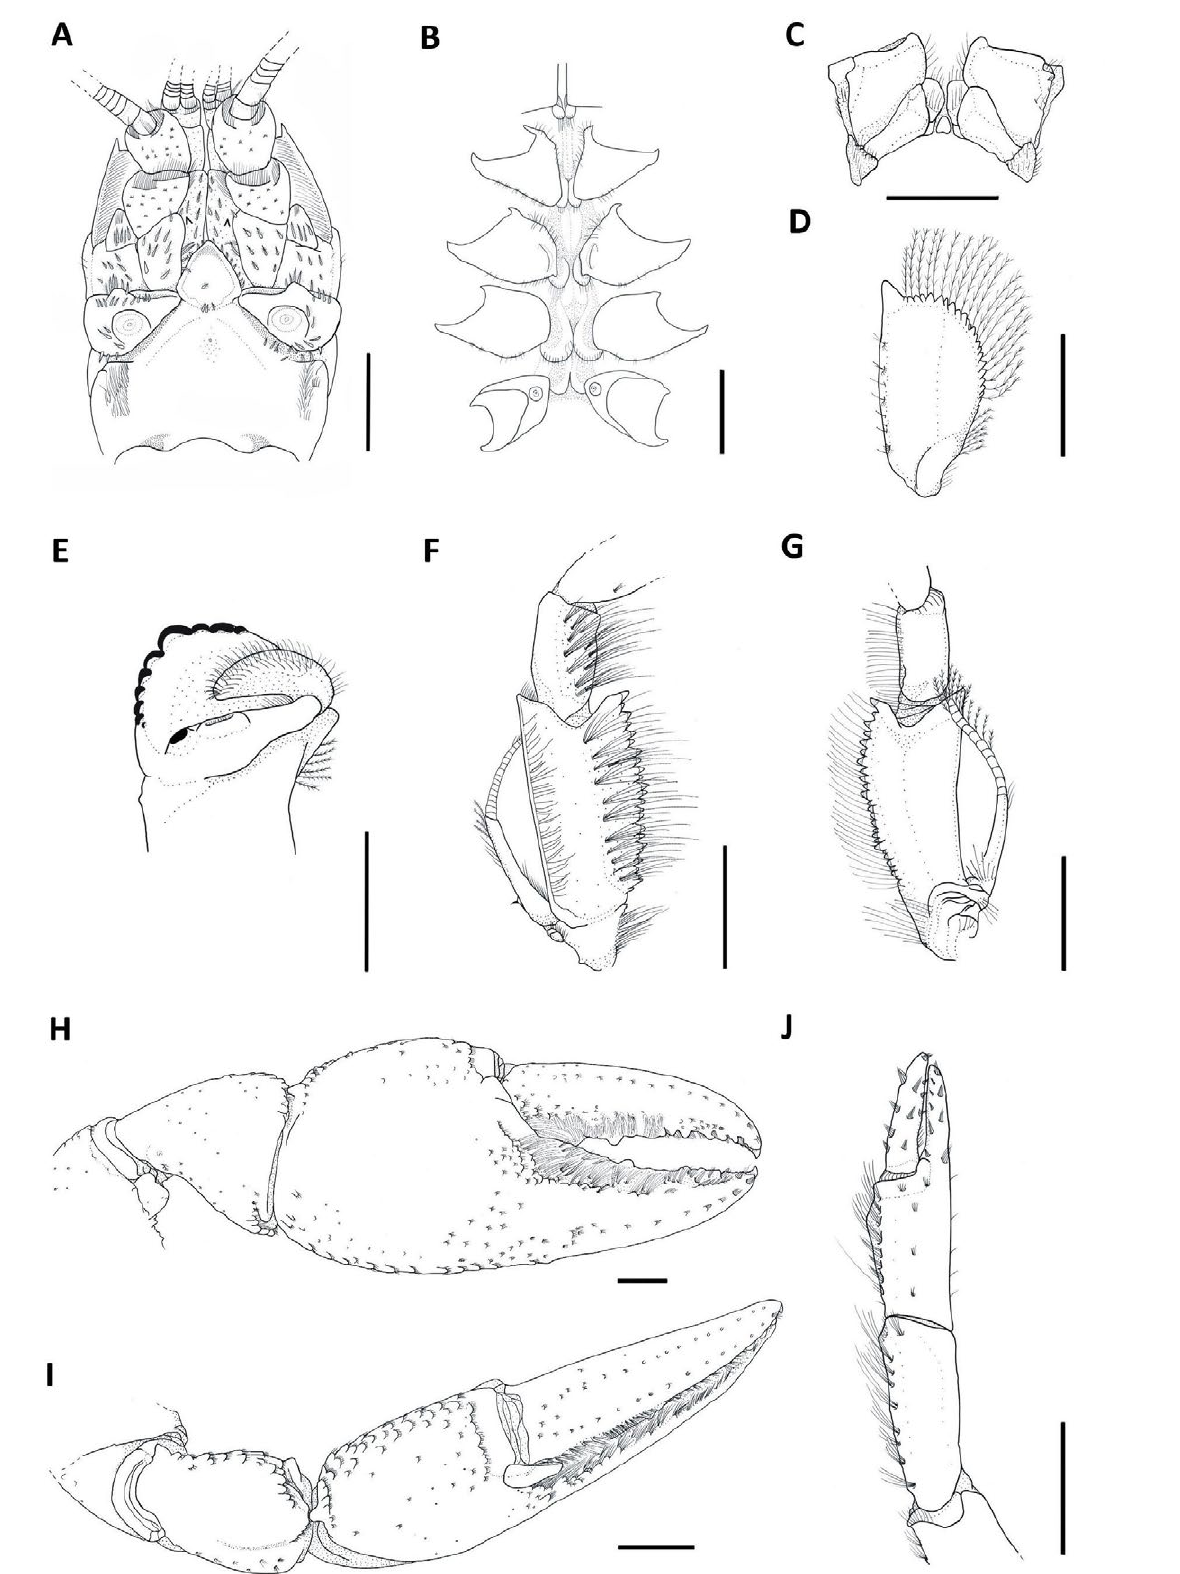
Figure 2. Parastacus buckupi sp. nov. A, epistome (holotype); B, thoracic sternites and gonopores (holotype); C, thoracomere 8, caudal view (holotype); D, antennal scale lateral view (paratype 4); E, mandible (paratype 4); F, third maxilliped ventral view (paratype 4); G, third maxilliped dorsal view (paratype 4); H, first pereiopod lateral view (holotype); I, first pereipod dorsal view (holotype); J, second pereiopod lateral view (holotype). Scale bars: A – 3.3 mm; B, H–J – 5 mm; C, D – 1.6 mm; F, G – 2.50 mm; E – 2.00